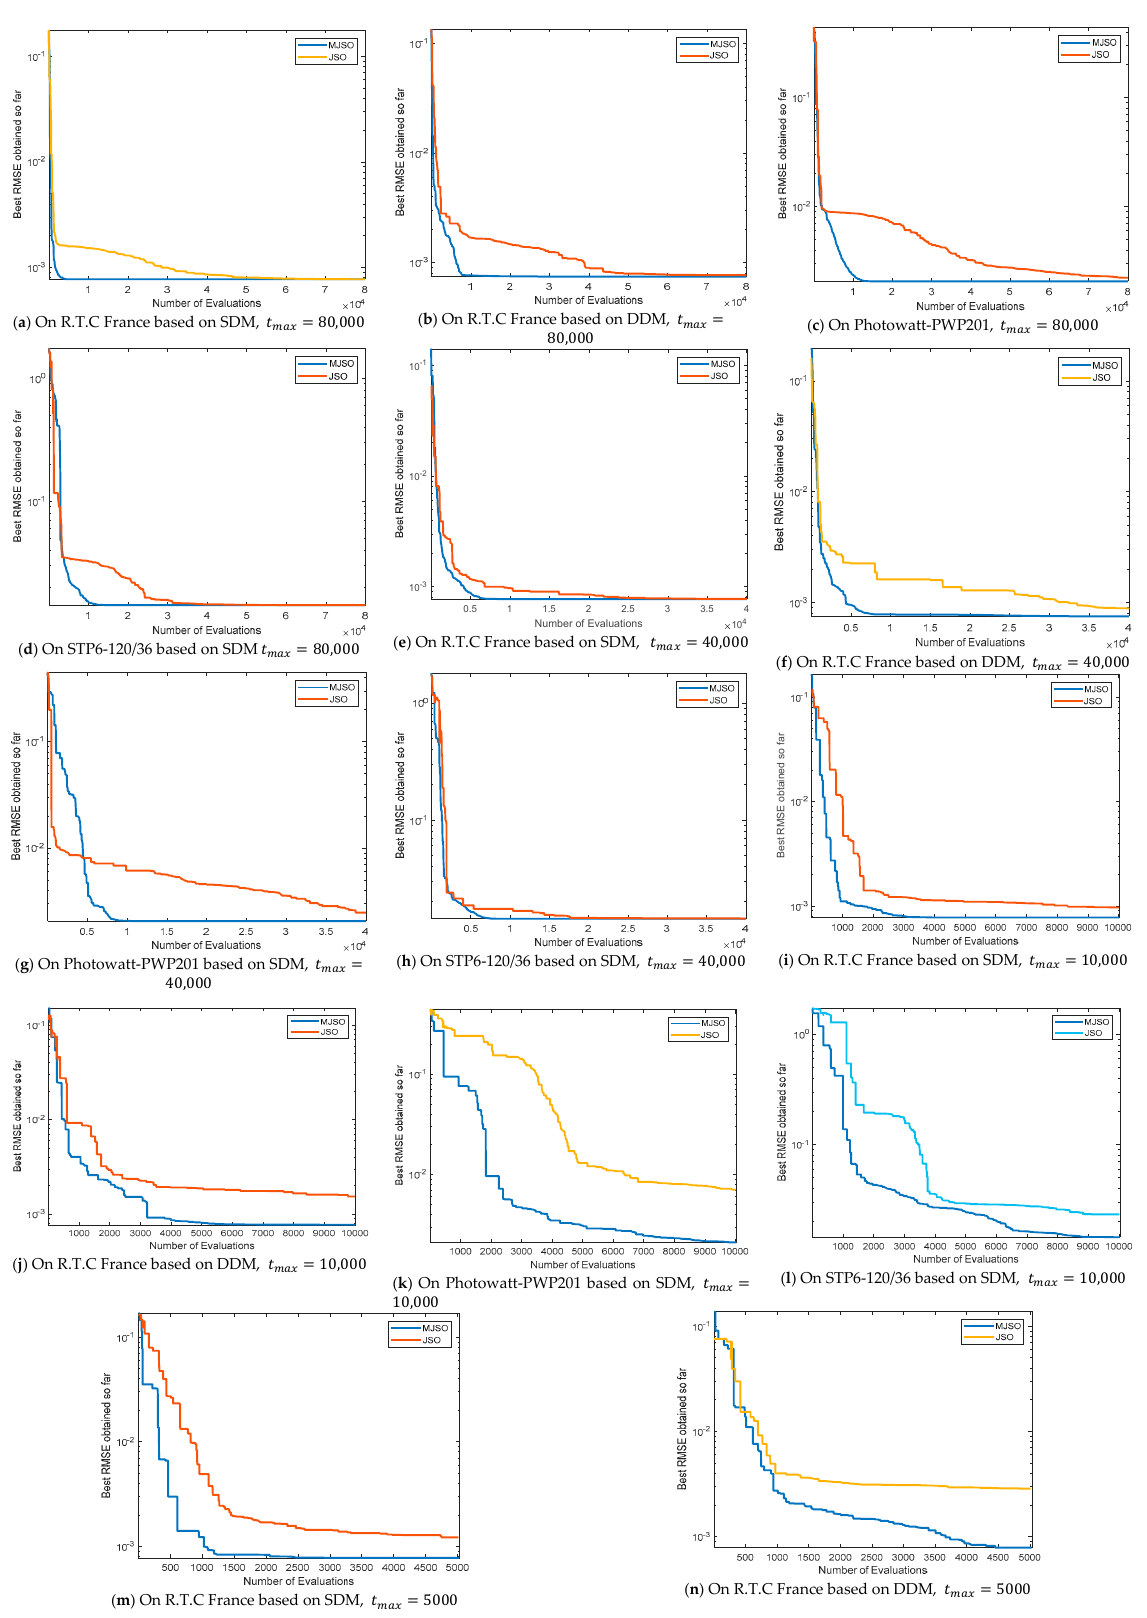
Figure 6. Comparison between the modified JSO (MJSO) and JSO under the convergence speed.